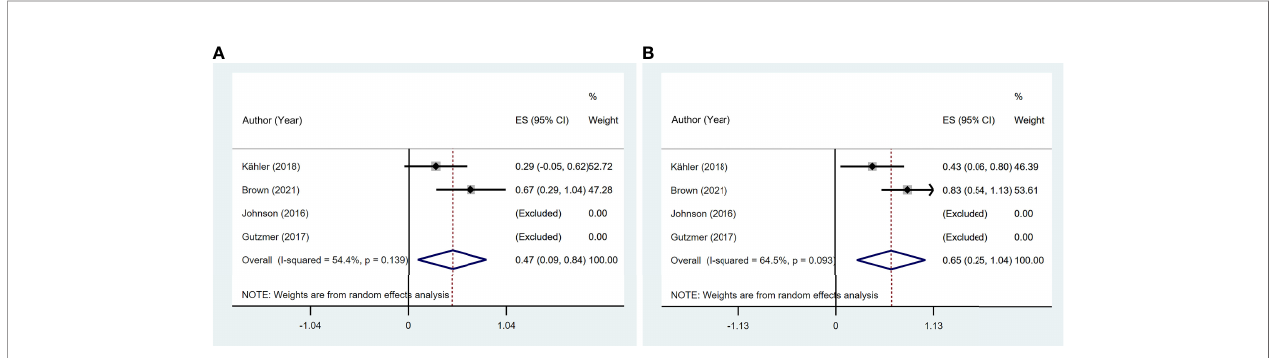
FIGURE 8 | The pooled ef fi cacy in immune checkpoint inhibitor (ICI)-treated patients with preexisting psoriasis and melanoma. (A) Objective response rate (ORR). (B) Disease control rate